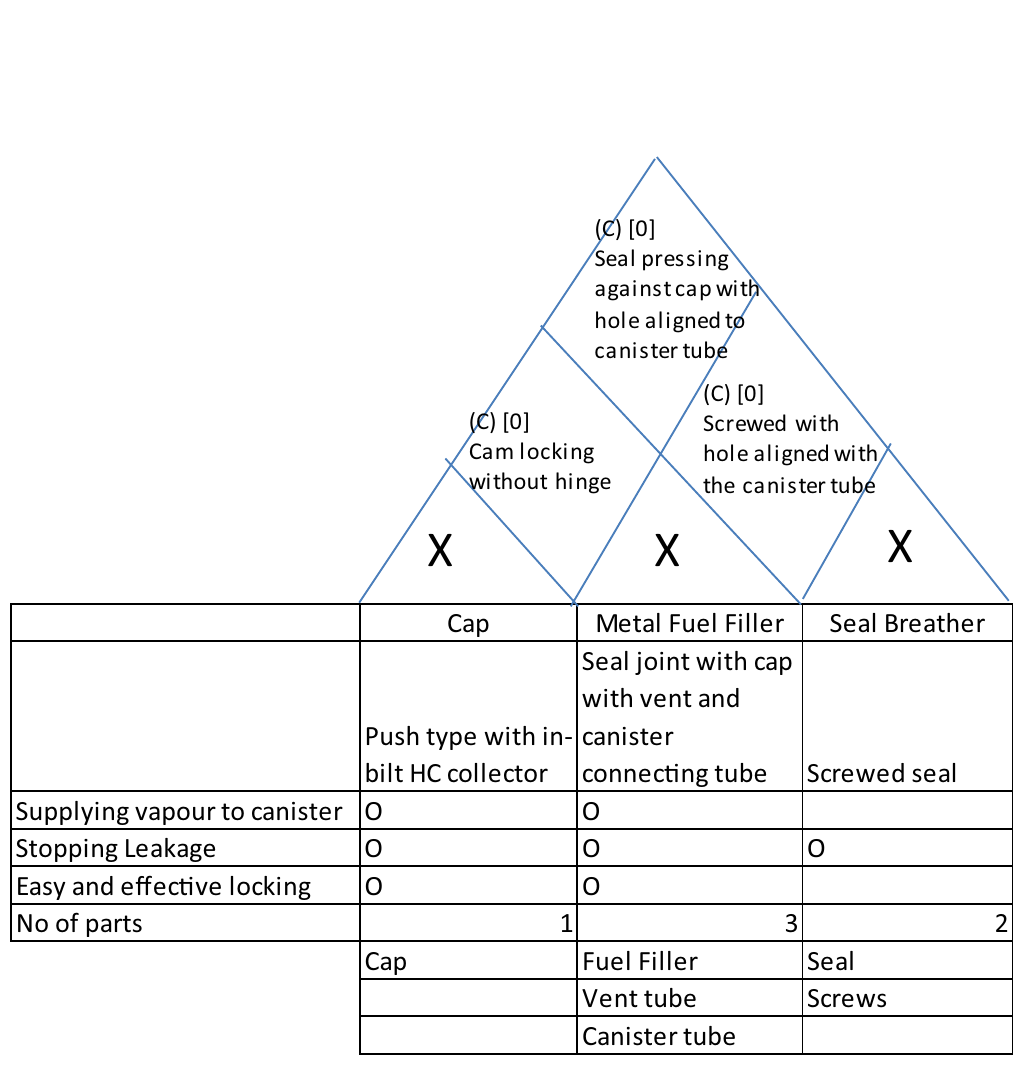
Table 3. House of architecture for the fuel